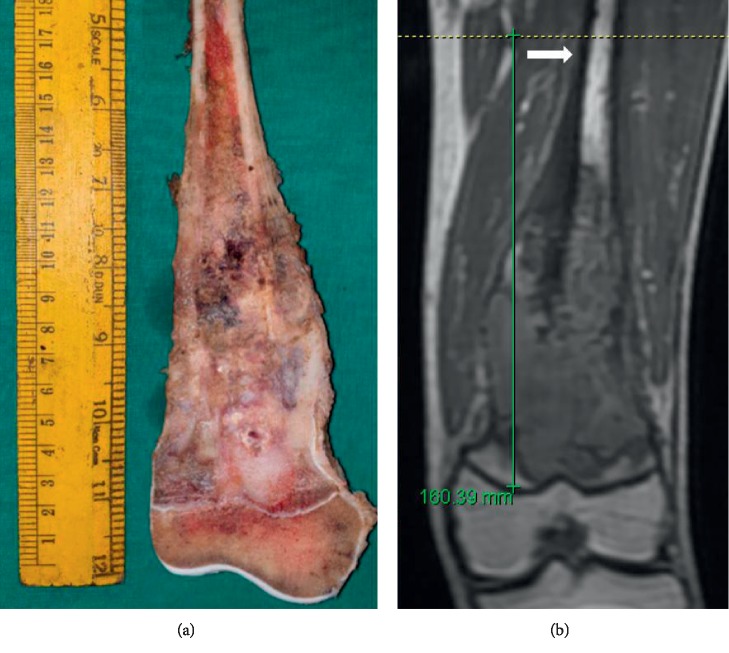
Tumor length measurements in the case of distal femur osteosarcoma on the gross specimen (a) 14 cm and noncontrast T1-weighted coronal MRI (b) 16 cm. Note that the white arrow indicates the periosteal reaction exceeds the intramedullary tumor extent.